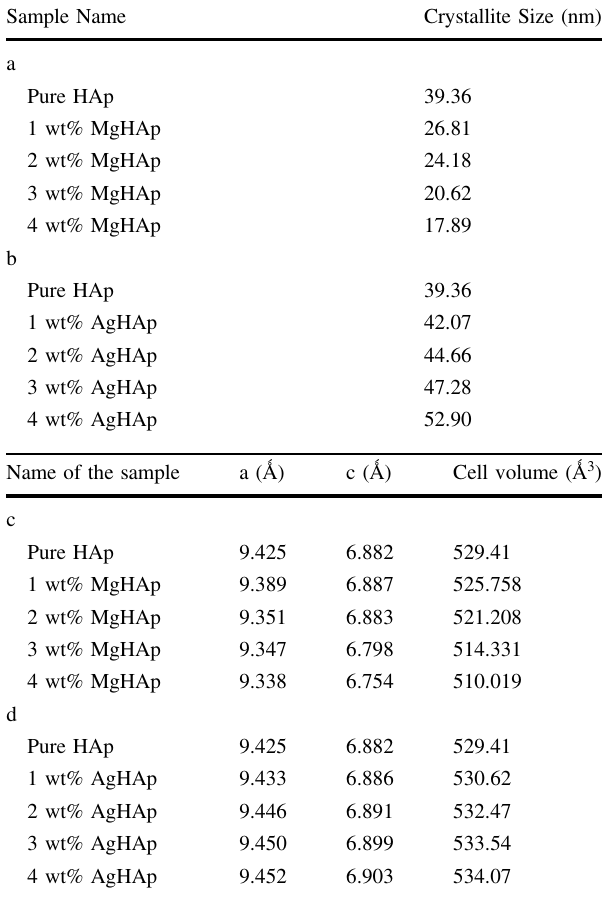
Table 1 a: The crystallite size of MgHAp samples as calculated from the Scherrer ’ s formula. b: The crystallite size of AgHAp samples as calculated from the Scherrer ’ s formula. c: The lattice parameters and cell volume computed for different weight percent of MgHAp. d: The lattice parameters and cell volume for different weight percent of AgHAp